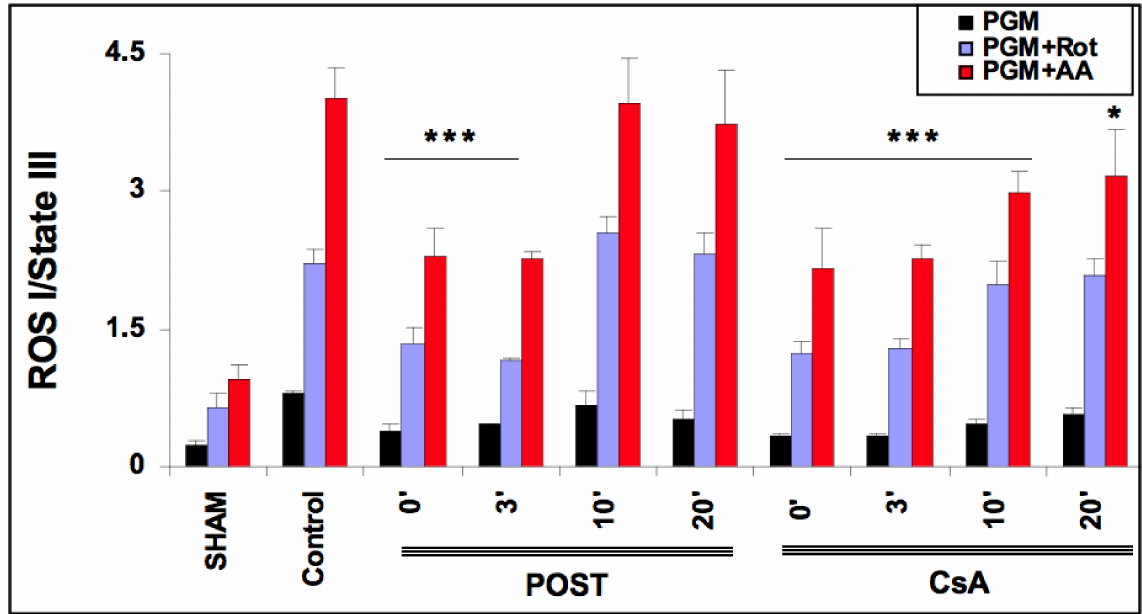
Figure 4. Extramitochondrial H 2 O 2 index assessed in the presence of pyruvate-glutamate-malate- (PGM), substrates of complex I, PGM + rotenone (Rot) and PGM + rotenone + antimycin (AA). 20 min after the onset of reperfusion, the H 2 O 2 index remained lower in the delayed CsA group but returned to control values in delayed POST-10 and -20. Abbreviations: CsA for cyclosporine A and POST for ischemic postconditioning. N = 6 hearts/group. * p < 0.05 and *** p < 0.001 vs.